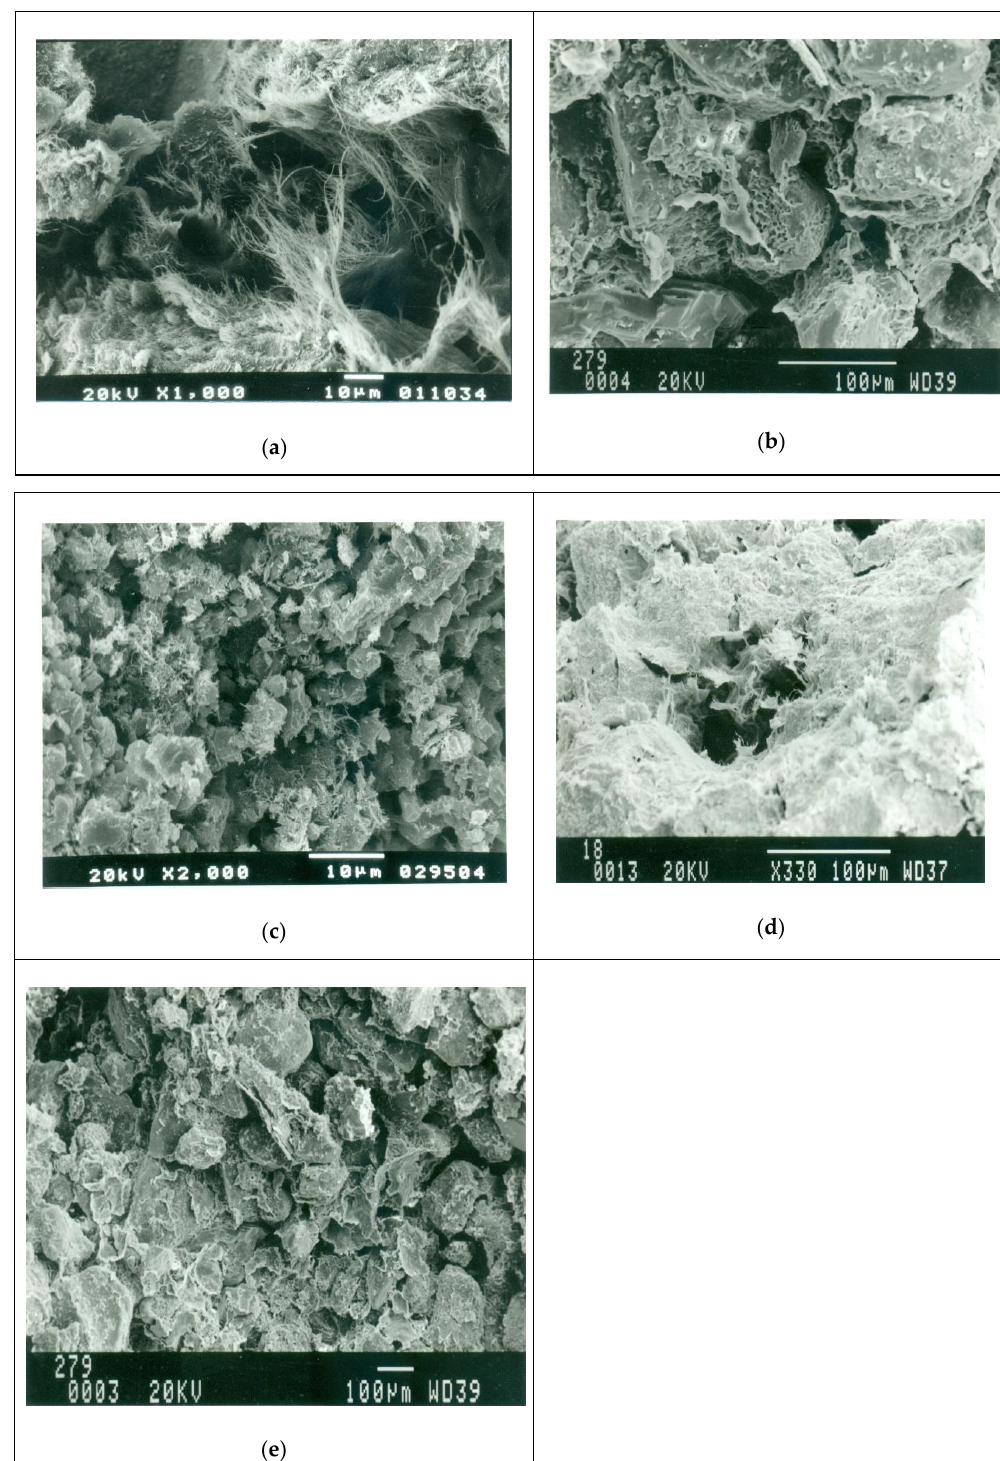
Figure 6. SEM images for in the study clays: ( a ) C1, ( b ) C2, ( c ) C3, ( d ) C4 and ( e ) C5.